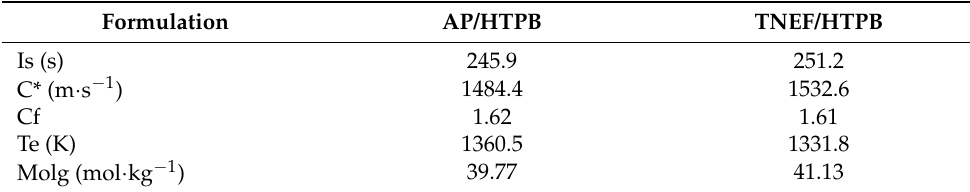
Table 3. Comparison between performance of AP/HTPB and TENF/HTPB propellant formulations